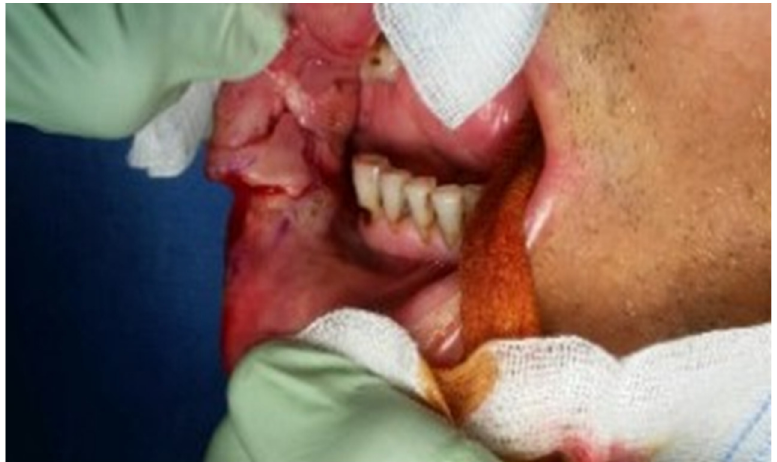
Figure 6. Case 2: Other view of the squamous cell carcinoma of the right commissure extending to the upper and lower lips.